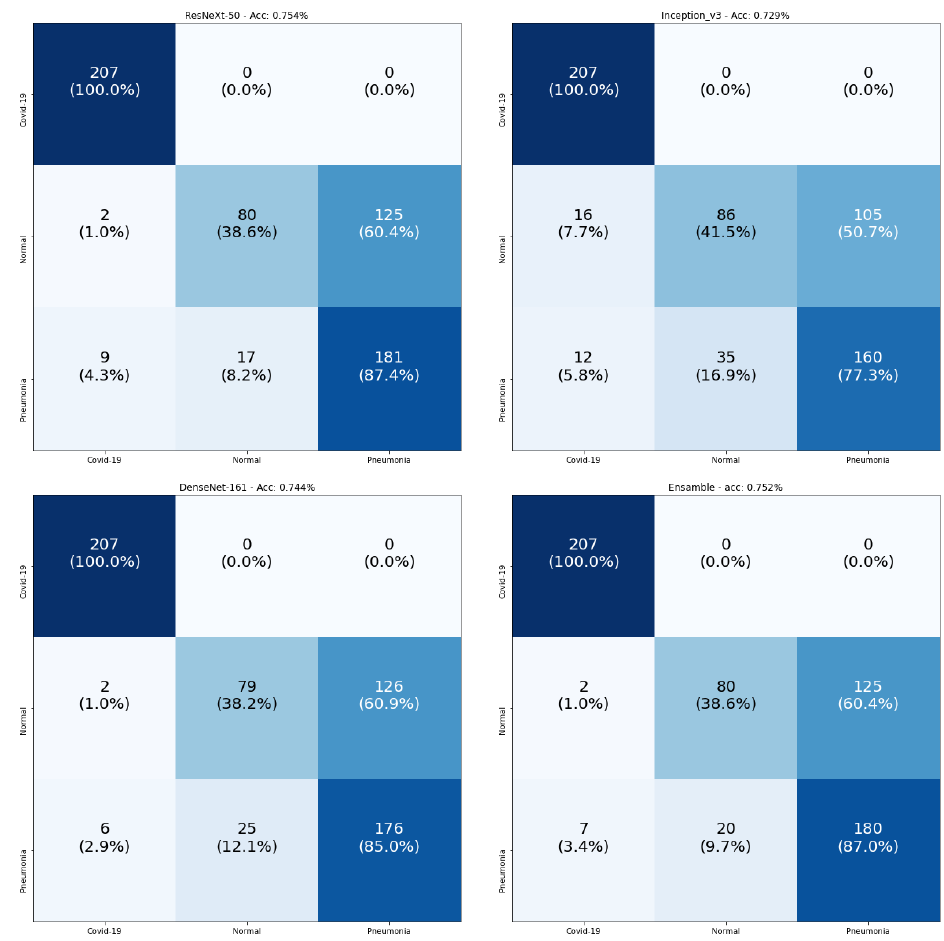
Figure 9. Confusion matrices of the three-class COVID-19 testing data using ResneXt-50, Inception- v3, DenseNet-161, and Ensemble-CNNs, respectively. The vertical axis is for the true classes and the horizontal axis is for the predicted classes.